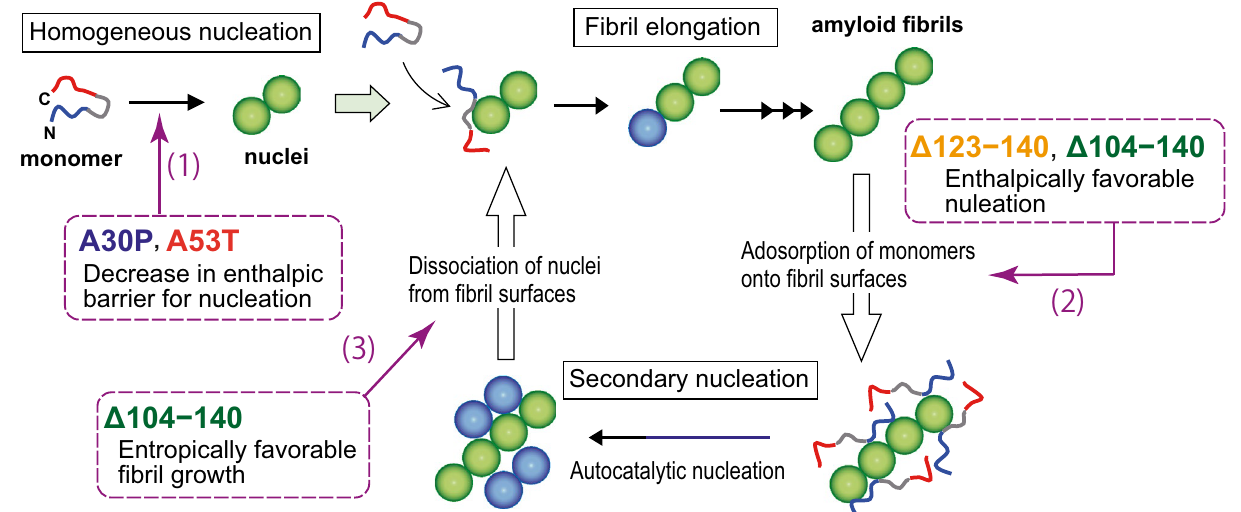
Figure 8. Schematic representation of the effects of the PD-related mutations or C-terminal truncations on the fibril-forming process of α-syn. Fibril formation of α-syn occurs through homogeneous nucleation and fibril elongation, whereas secondary nucleation process contributes to the autocatalytic enhancement of fibril formation at high initial monomer concentration (≥ 100 μM). Both the A30P and A53T mutations enhance the homogeneous nucleation by decreasing the enthalpic barrier for nucleation (1). The enthalpically favorable nucleation of the Δ123–140 and Δ104–140 variants suggests the enhanced adsorption of monomers onto